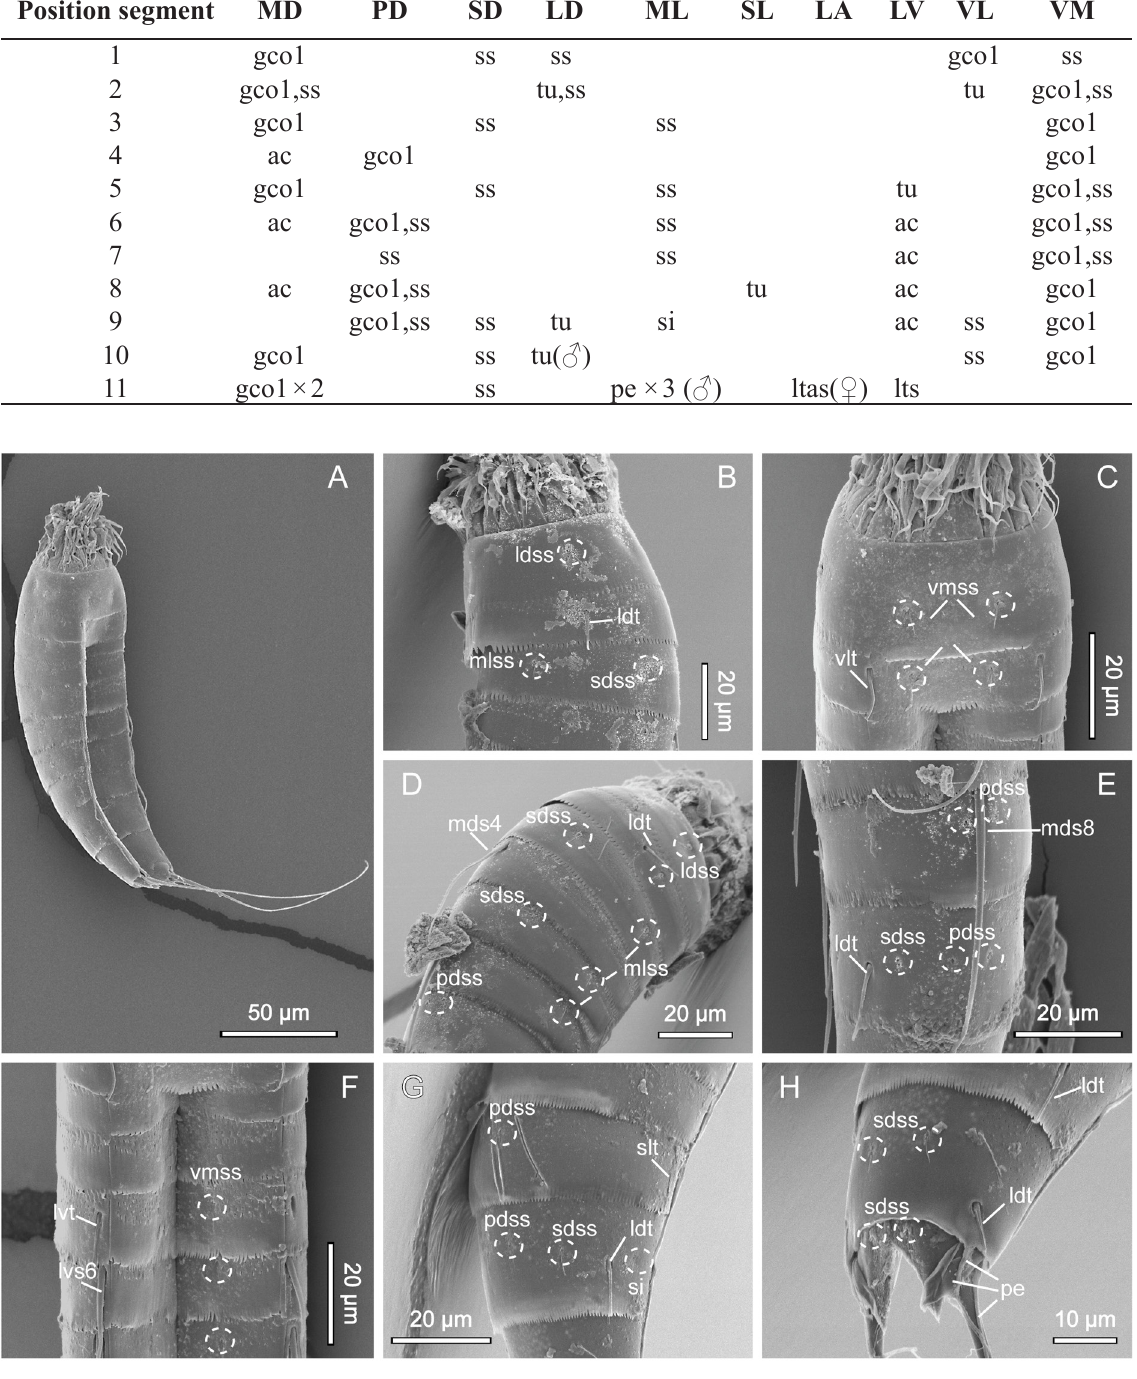
Fig. 13. Scanning electron micrographs showing overviews and details of Echinoderes leduci sp. nov. A . Lateroventral overview. B . Segments 1 to 3, lateral view. C . Segments 1 to 3, ventral view. D . Segments 1 to 6, laterodorsal view. E . Segments 8 to 9, dorsal view. F . Segments 3 to 7, ventral view. G . Segments 7 to 9, laterodorsal view. H . Segments 10 to 11 of male, dorsal view. Abbreviations: see Material and methods.